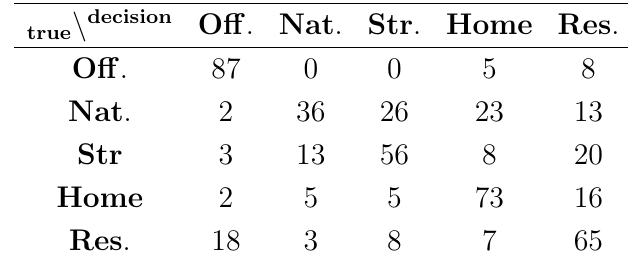
Table 9. Confusion matrix of five environment classes office , nature , street/road , home and restaurant/pub/cafe using the support vector machine classifier. The values denote